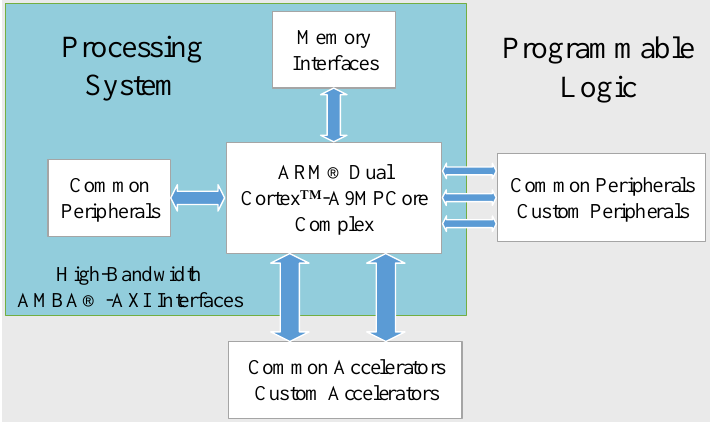
Figure 9. The internal structure of the